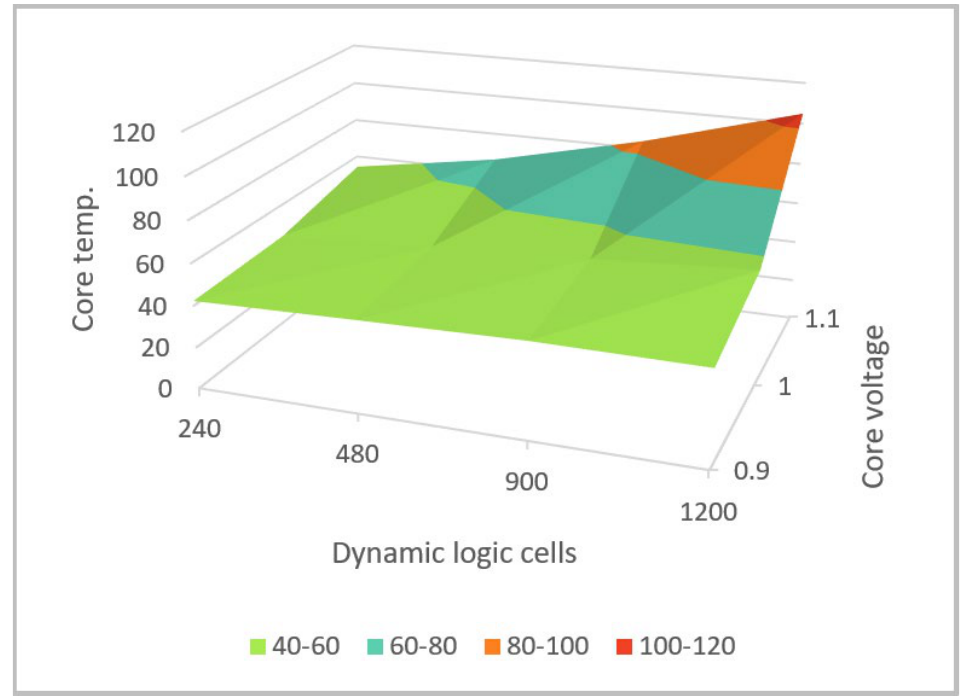
Figure 3. Surface plot showing the increase in core temperature due to dynamic power dissipation with an ambient temperature of 25 ◦ C. The plot shows the temperature increase with the increase in the number of dynamic logic cells, as well as the increase in voltage.